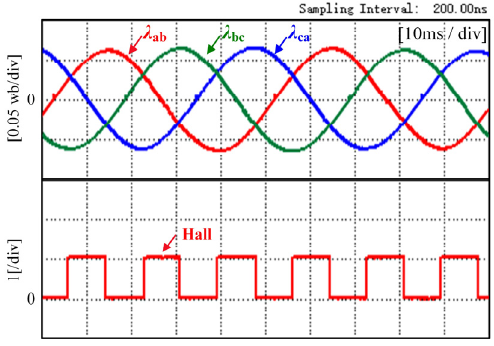
Figure 9. Line-to-line PM flux linkage and Hall signal waveform at 300 r/min.